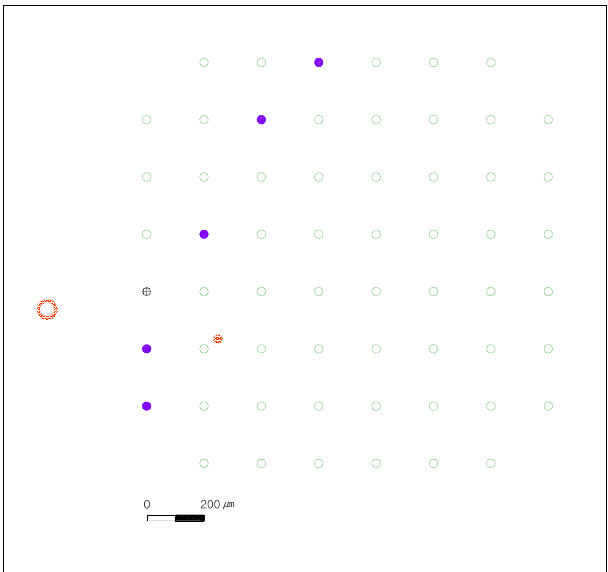
Figure 7. The dual-monopolar stimulation results . ( a ) The spatial response map of the dual-monopolar stimulation. ( b ) The contour diagram of the dual-monopolar stimulation. The numbers on the contour diagram are the evoked RGC spike numbers with respect to 50 μ A current stimulation. ( c ) Electrode